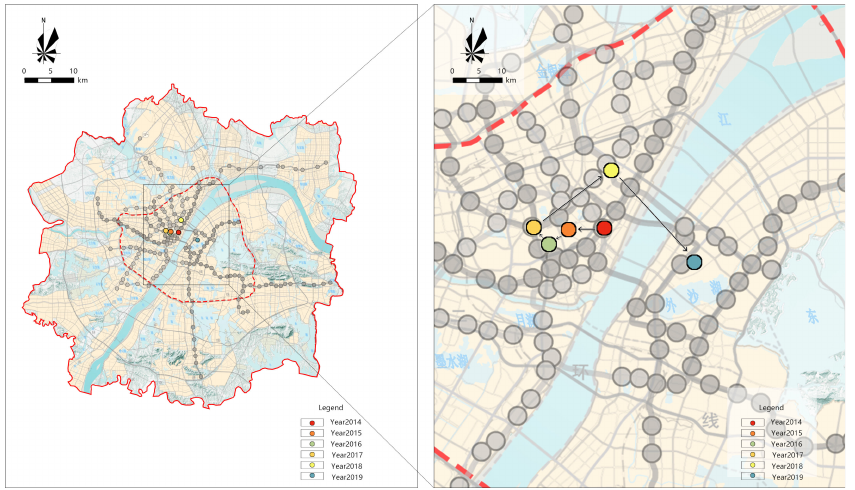
Figure 5. The migration of the accessibility gravity of Wuhan rail transit network in